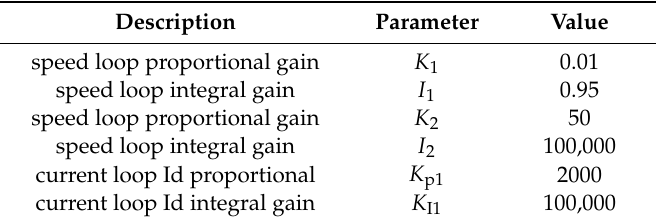
Table 2. The cascade PID controller.